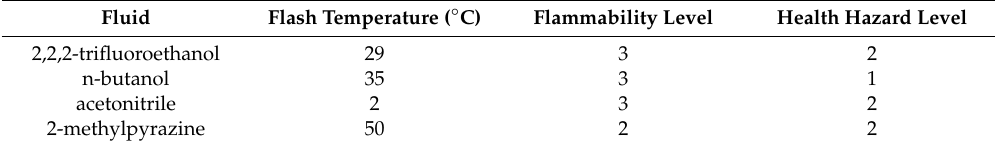
Table 2. Flash temperatures and health hazard level of the investigated working fluids.